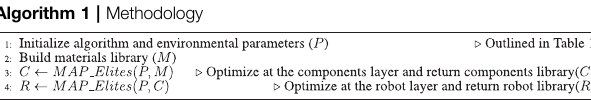
Algorithm 1 . One of the obvious bene fi ts of this layered approach is